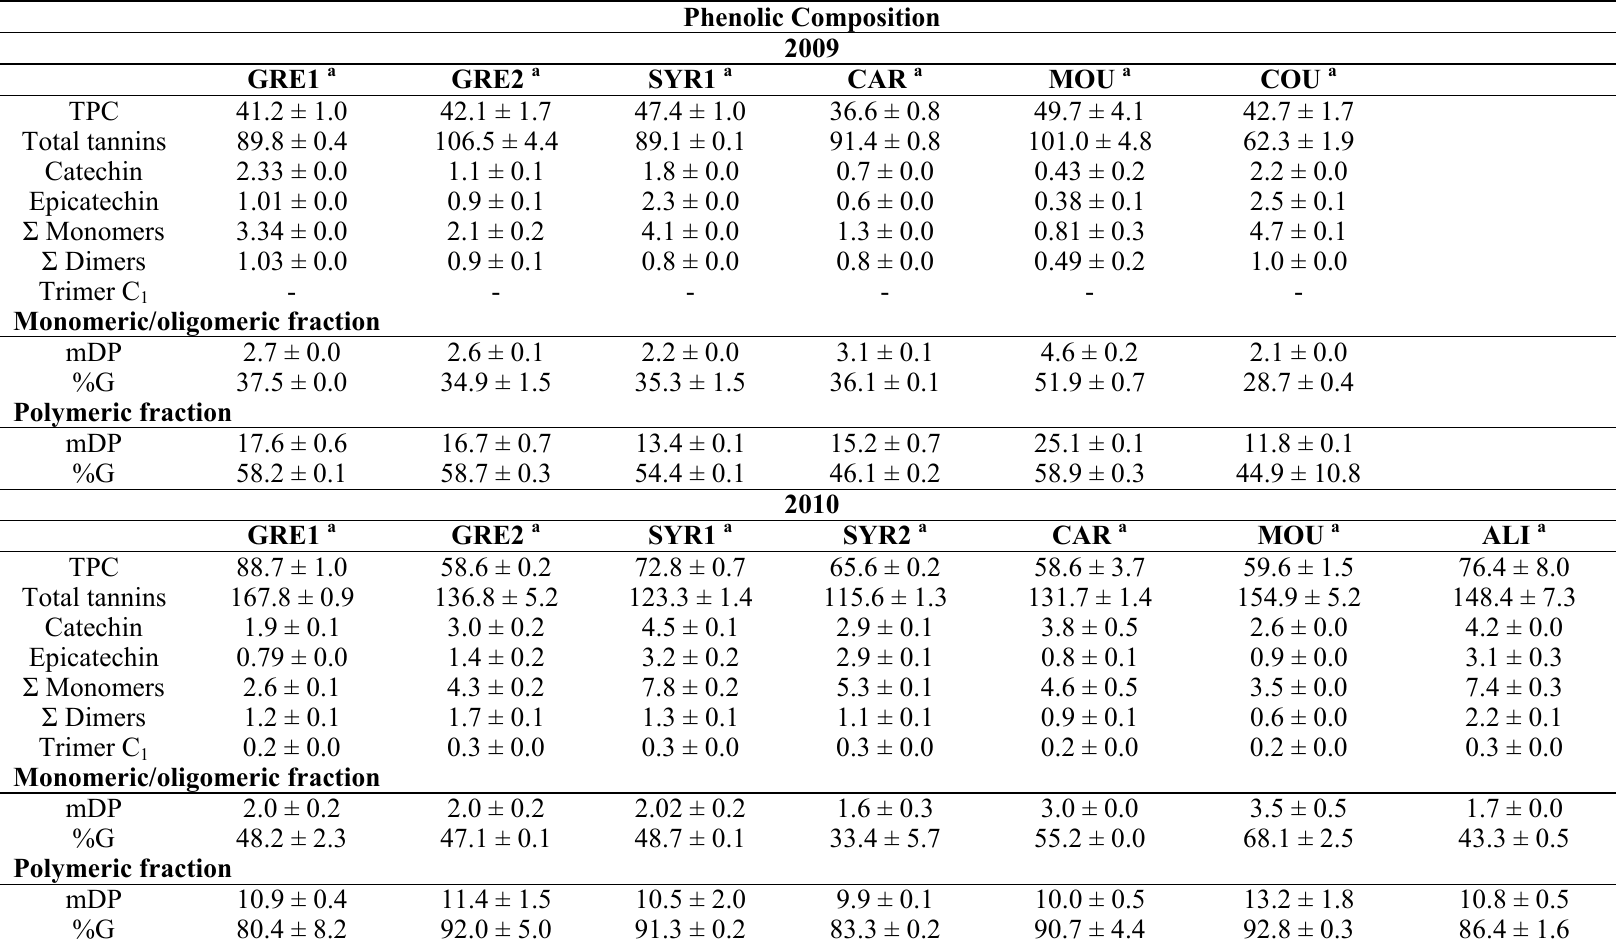
Table 1. Phenolic composition of grape seeds in 2009 and